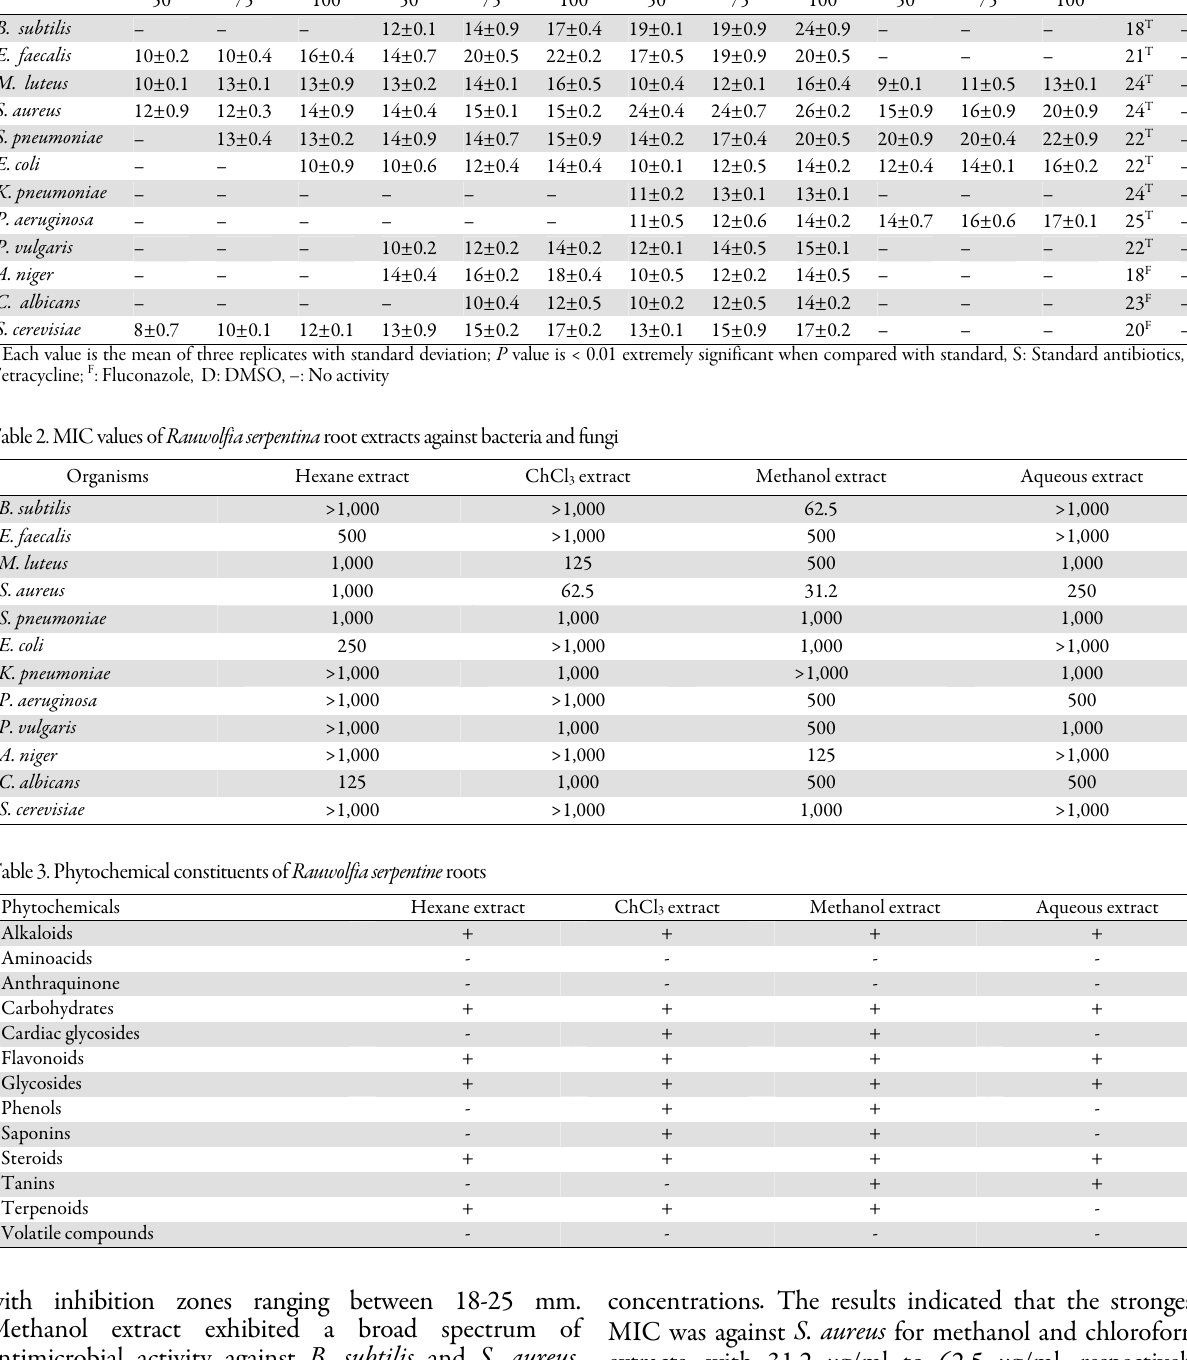
Table 1. The antimicrobial activity of Rauwolfia serpentina against various pathogens